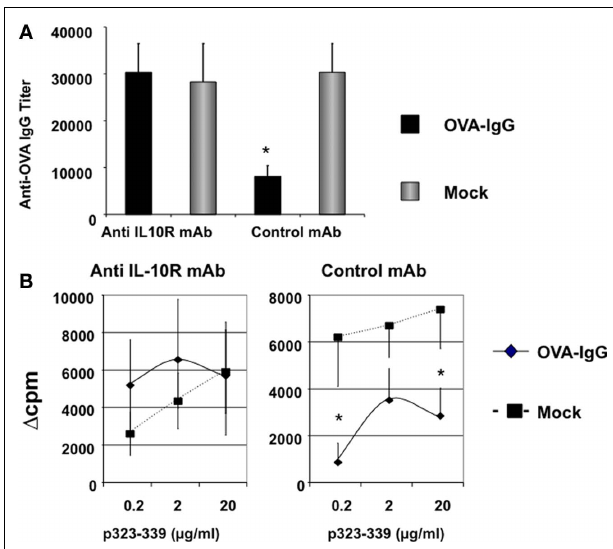
FIGURE 3 | IL-10 produced by the host is required for tolerance induction by peptide–IgG transduced B cells. LPS-activated wt B cells were transduced with OVA–IgG or a mock control vector (PLP) and 1 × 10 7 B cells per mouse were injected i.p. into naïve C57BL/6 recipients on day 0. Seven days later, mice were immunized with 25 μ g OVA protein emulsified in CFA via a hind footpad and the base of tail.Two weeks after immunization, mice were sacrificed and assayed for CD4 + T-cell and antibody responses. On day − 3, 0, 7, and 14, mice were injected i.p. four times with 1mg/mouse of anti-IL-10R (1B1.3a, rat IgG1) or control mAb (GL113, anti- E.coli β -galactosidase, rat IgG1).The antibody (A) andT-cell responses (B) were assayed and presented as described in Figure 1 legend.Values represent mean ± SE of antibody titers or mean (cid:2) cpm ± SE. ( n = 4). Data are representative of two independent experiments.